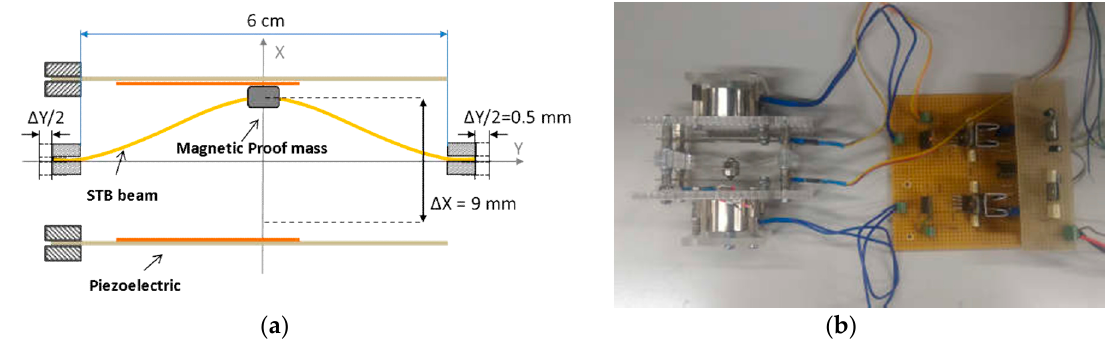
Figure 1. The nonlinear STB energy harvester. ( a ) A schematization of a top view of the device; ( b ) A